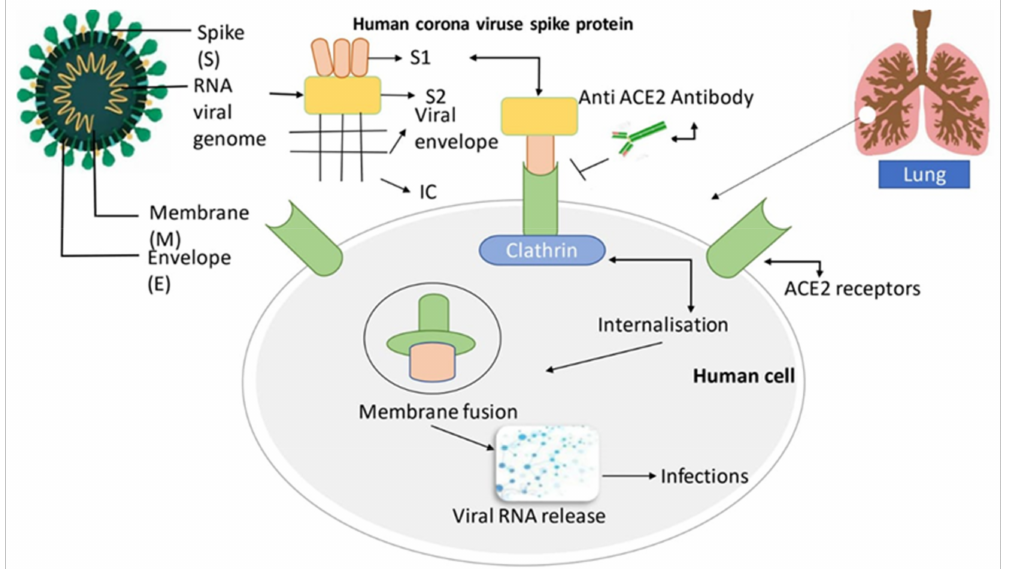
Figure 2. The structure of the SARS-CoV-2 virus. Clathrin is a protein that plays a vital role in the formation of coated vesicles. The S protein is an important element of the viral shape that helps the virus to connect with the host receptor cells. The S protein comprises two parts: the receptor-binding component S1 and the membrane fusion component S2; the former attaches to the human host cell’s ACE2 receptor, while the latter internalizes and forms a membrane fusion between the viral component and the ACE2 receptors. This causes the viral RNA to be released into the host cell, resulting in respiratory infection [75]. Adapted with permission from ref. [75]. Copyright 2020 Elsevier